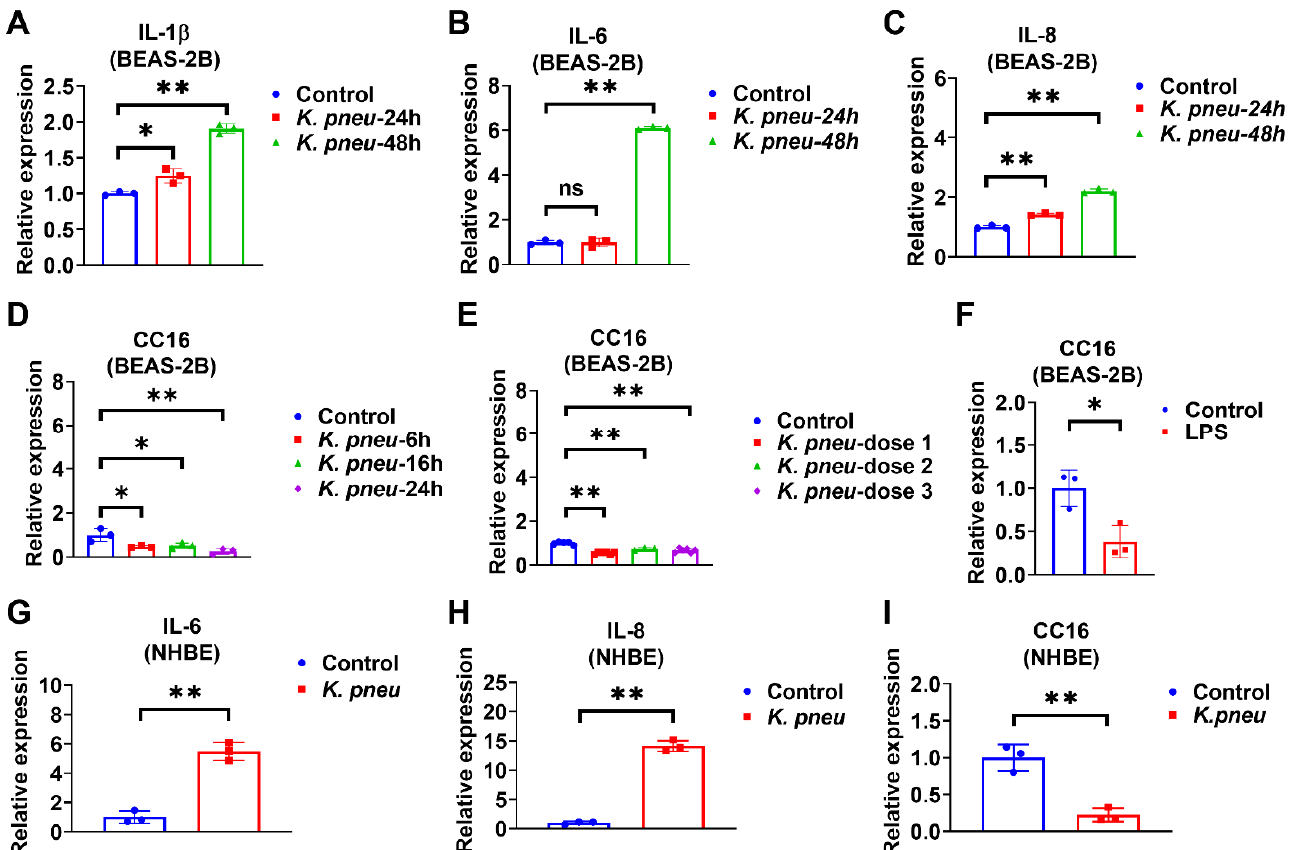
Figure 1. K. pneu infection decreases CC16 expression in bronchial epithelial cells and increases the proinflammatory cytokines at different time points. The mRNA levels of proinflammatory cytokines and CC16 were detected from human lung epithelial cells, BEAS-2B cells, which were infected with a cell: K. pneu ratio of 1:5 for one hour and then BEAS-2B cells were incubated with 50 µg/mL of gentamycin for the indicated time before mRNA levels were measured ( A–D ). mRNA expression levels of IL-1 β ( A ), IL-6 ( B ), and IL-8 ( C ) after K. pneu infection in BEAS-2B for 24 h and 48 h. ( D ) CC16 mRNA expression levels after K. pneu infection in BEAS-2B cells for 6 h, 16, and 24 h. ( E ) CC16 mRNA expression levels in response to a different amount of K. pneu infection; dose 1; a cell: K. pneu ratio of 1:5, dose 2; a cell: K. pneu ratio of 1:10, dose 3; a cell: K. pneu ratio of 1:15. ( F ) CC16 mRNA expression levels after treating 200 ng/mL of LPS treatment for 24 h. ( G-I ) NHBE cells were infected with a cell: K. pneu ratio of 1:5 for one hour. After removing the bacteria, NHBE cells were cultured for 24 h with 50 µg/mL of gentamycin. The mRNA expression levels of IL-6 ( G ), IL-8 ( H ), and CC16 ( I ) were measured using real-time qPCR. Results represent mean ± SD of 3 independent experiments . * p < 0.05, ** p < 0.01.